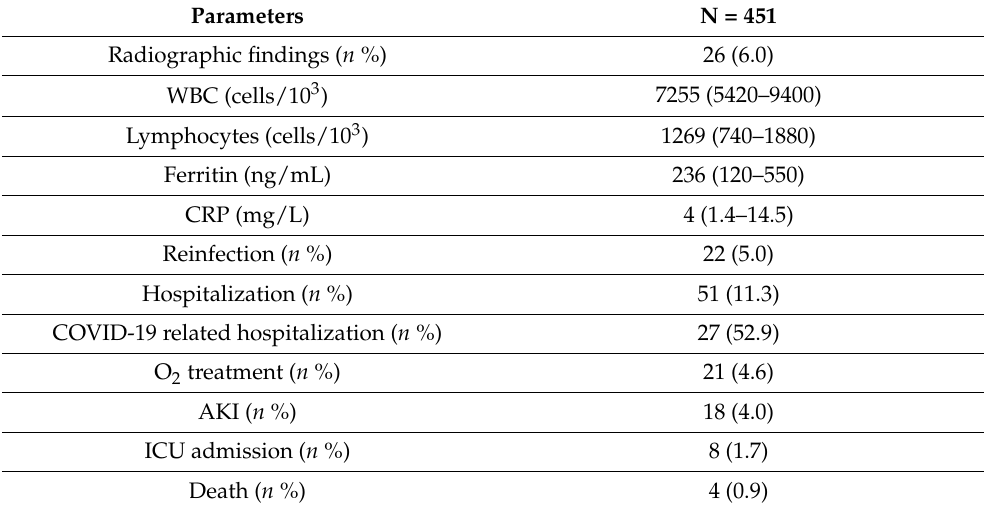
Table 3. Disease course and outcomes.